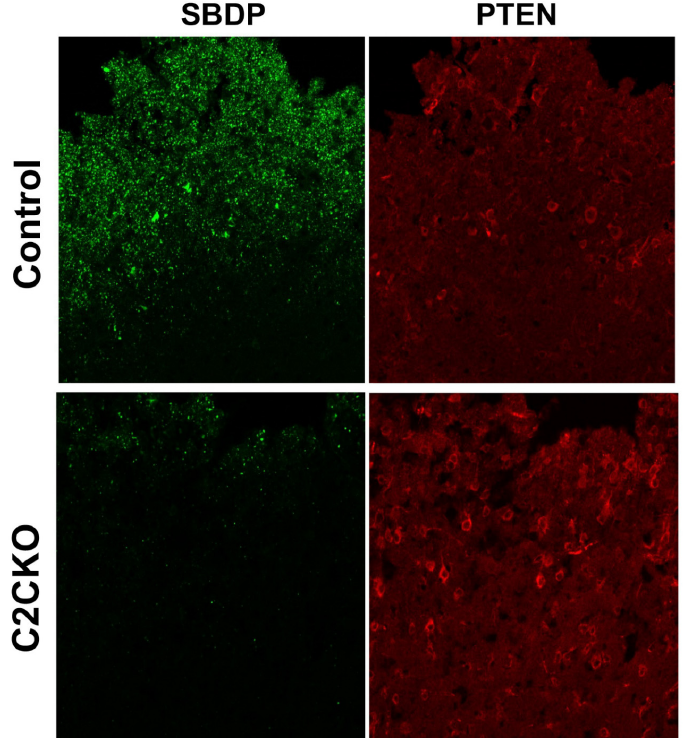
Figure 3. Changes in spectrin breakdown product (SBDP) and Phosphatase and Tensin Homolog (PTEN) around the lesion site in control and C2CKO mice after TBI. IHC with antibodies targeting SBDP (1:500, a gift from Dr. Saido, Riken, Japan) and full-length PTEN (1:600, 9556, Cell Signaling) around the lesion site was performed in control and C2CKO mice 24 h after TBI. Note that the levels of SBDP were much lower while PTEN levels were much higher in C2CKO mice as compared to control mice. Scale bar: 50 μ m.